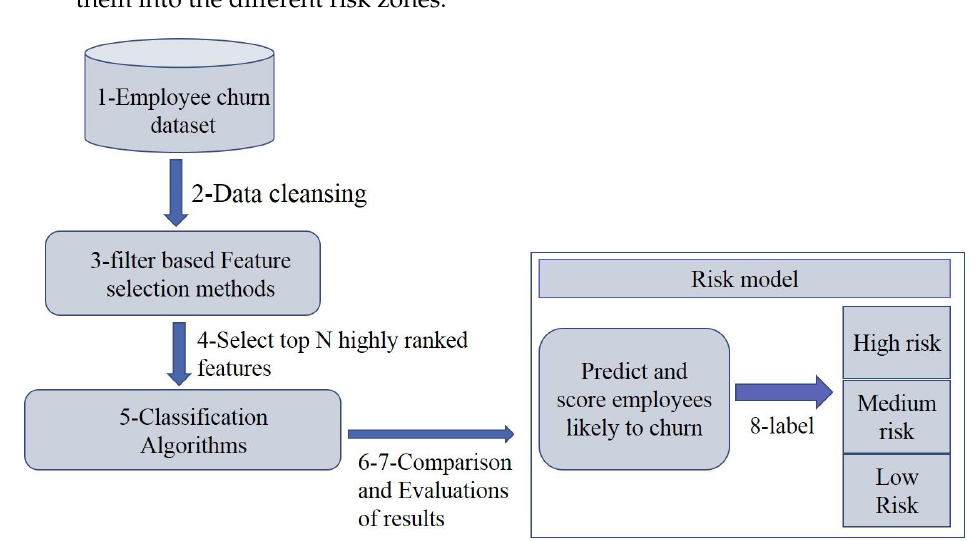
Figure 1. Employee churn analysis for IoT-enabled software industry.